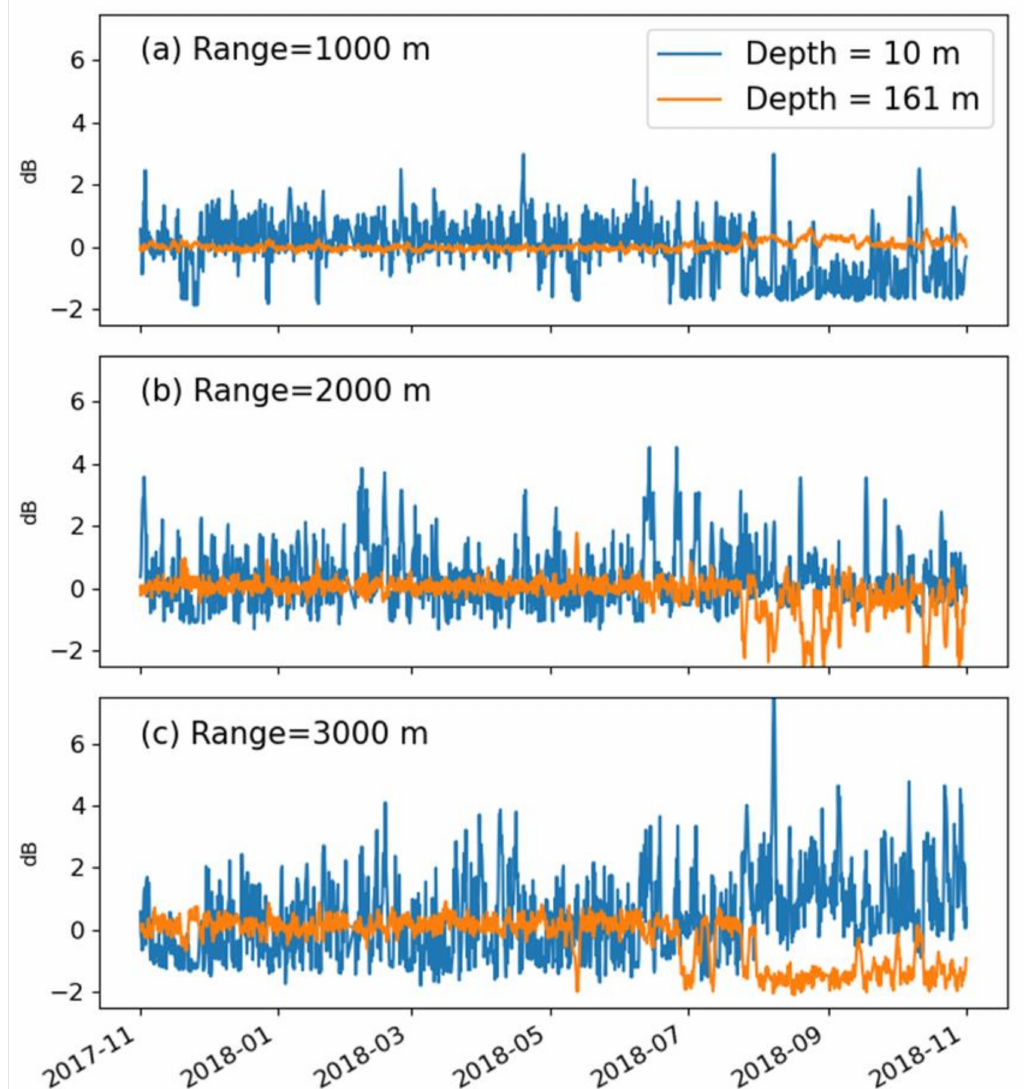
Figure 10. Departures from the annual median of the modeled TL for two depths: 10 and 161 m, corresponding to typical dive depths of SRKW and the location of the PAM mooring, respectively. Results taken from modeled TL for source receiver ranges of ( a ) 1000 m, ( b ) 2000 m and ( c ) 3000 m, and a source depth of 7 m, representing a commercial deep-sea